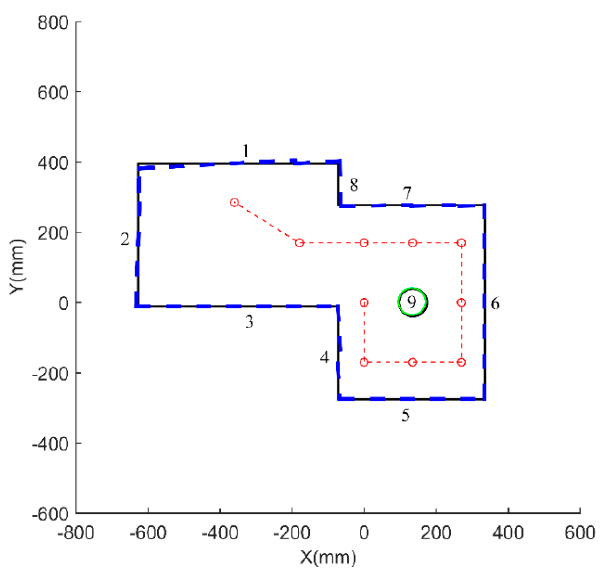
Figure 13. Mapping construction result.